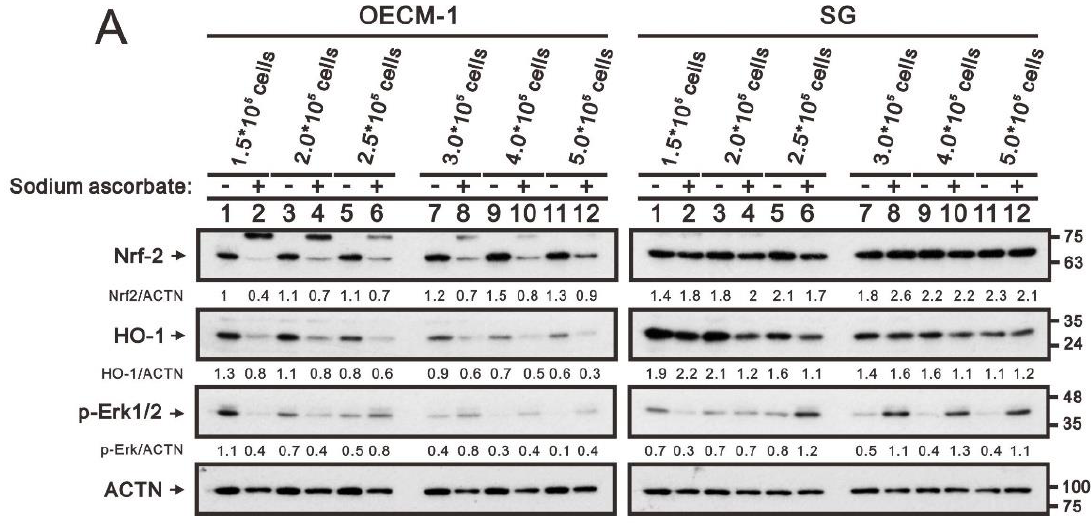
Figure 5. Effects of sodium ascorbate and L-ascorbic acid on Nrf2, HO-1, and p-Erk proteins in OECM-1 and SG cells. Indicated cell densities of OECM-1 and SG cells were cultured in 6-well plates and treated with 10 mM ( A ) sodium ascorbate for 3.5 h or ( B ) L-ascorbic acid for 5.5 h. The cell lysates (30 µg total proteins) were subjected to Western Blot analysis using antibodies against the indicated proteins. ACTN was a loading-protein control. The protein bands ( A ) and ( B ) were quan- tified through pixel density scanning and evaluated using Image J, version 1.44a (http://im- agej.nih.gov/ij/) (accessed on 1 February 2023). The ratios of protein/ACTN were listed in the OECM-1 and SG cells. 2.3. The Effect of Ascorbate on Cytosolic and Mitochondrial ROS Generation in OECM-1 and SG Cells Nrf2 is a master protein that responds to the status of reactive oxygen species (ROS) in cells. It was interesting to address the status of ROS at a pharmacologic concentration of L-ascorbic acid and sodium ascorbate in OECM-1 and SG cells. We measured the cyto- solic ROS levels of both types of cells using flow-cytometry analysis with DCFH-DA dye (Figure 6A – D). Our data showed that sodium ascorbate decreased the ROS levels in both cell lines in a dose-dependent manner (Figure 6A,C). However, L-ascorbic acid first de- creased the ROS level and then returned to the increasing level in both cells (Figure 6B,D).